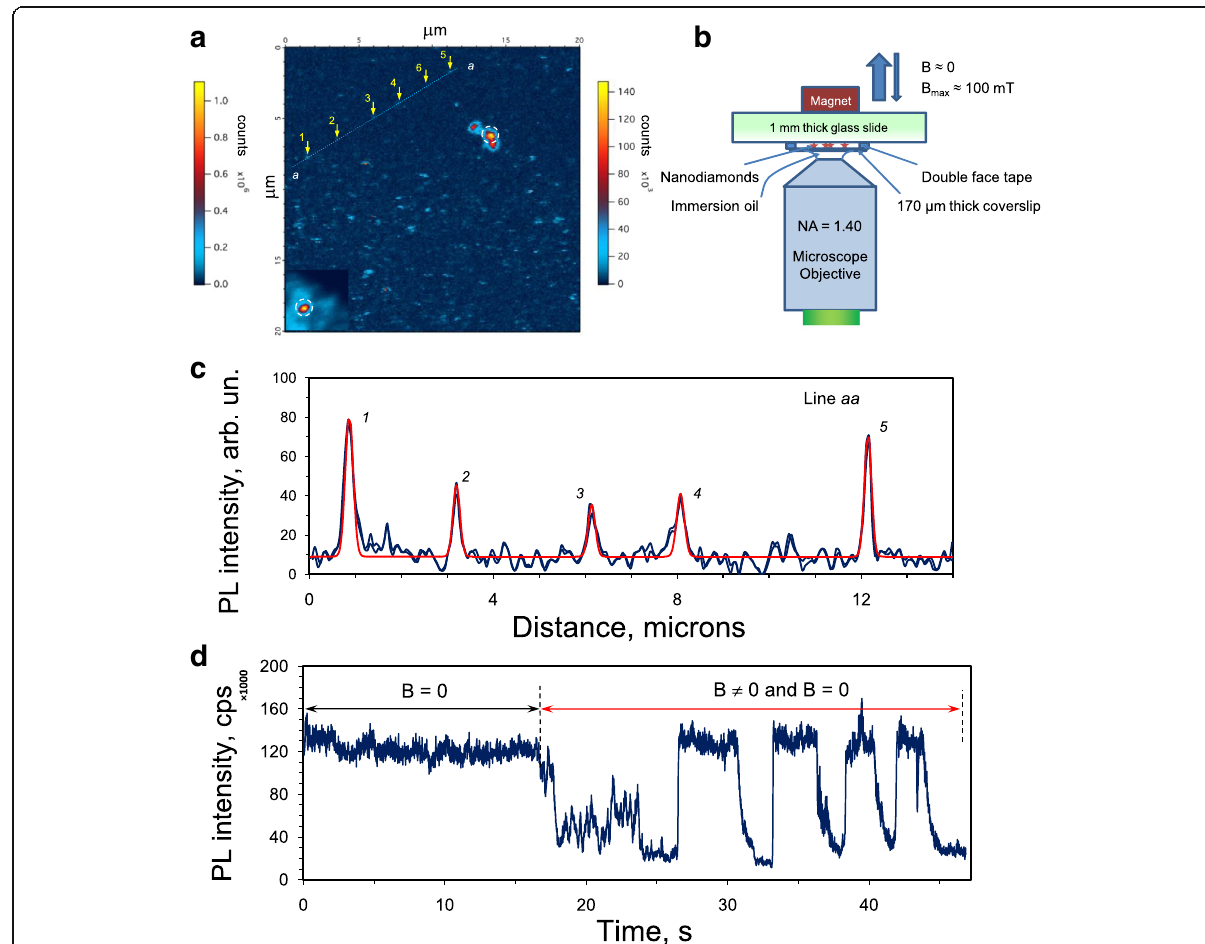
Fig. 7 a 2D-colour mapping of the PL signal intensity of DND spin-coated on a glass microscope coverslip together with b schematics of the experimental setup. c The PL intensity profile along the “ aa ” cross-section. d The photoluminescence intensity versus time for the selected DND aggregate marked with a circle in the upper side of the 2D map shown in panel a , in the presence or absence of an external magnetic field. Laser excitation at 532 nm wavelength. Square, 201 × 201 pixels. Integration time is 3 ms/pixel. Step — 100 nm. The excitation radiation is focused on the upper surface of the glass coverslip with deposited DND. In zero field ( B = 0), only small changes of intensity, due to the blinking of some of the NV − colour centres occur. When magnetic field is temporally applied a large decrease of the PL intensity occurs. Upper left panel a : the left scale for PL intensity corresponds to the 2D mapping of another DND aggregate shown in the left bottom corner of the large 2D map. Upper right panel b : schematics of the experimental setup explaining the displacement of